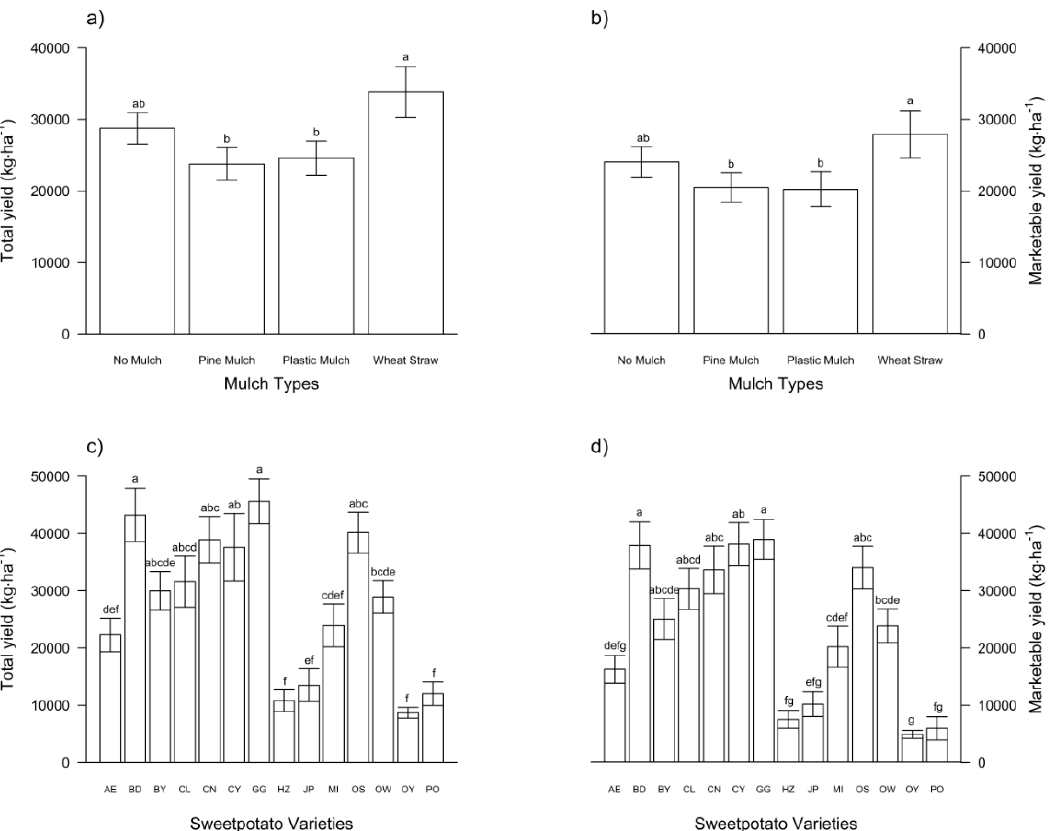
Figure 2. Main effects of different mulch types and varieties on total and marketable yields of sweetpotato roots. Error bars are one standard error of the mean. Different letters denote a significant difference by Tukey’s Honestly Significant Difference at α < 0.05. ( a ) Total yields of sweetpotato across by mulch type with control as no mulch; ( b ) marketable yields of sweetpotato across by mulch type with control as no mulch; ( c ) total yields of sweetpotato across varieties: AE = All Purple; BD = Beauregard; BY = Burgundy; CL = Centennial; CN = Covington; CY = Carolina Ruby; GG = Ginseng; HZ = Hernandez; JP = Japanese Purple; MI = Murasaki; OS = Orleans; OW = Old Yellow; OY = O’Henry; PO = Porto Rico; ( d ) marketable yields of sweetpotato across varieties.